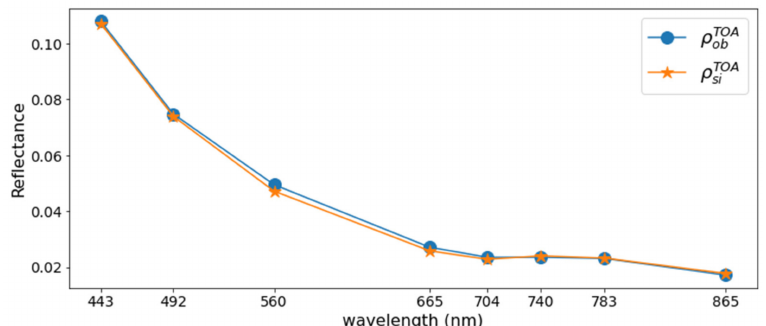
Figure 15. Comparison of the S2/MSI observed ( ρ TOA the location of the sampling station (11-631).